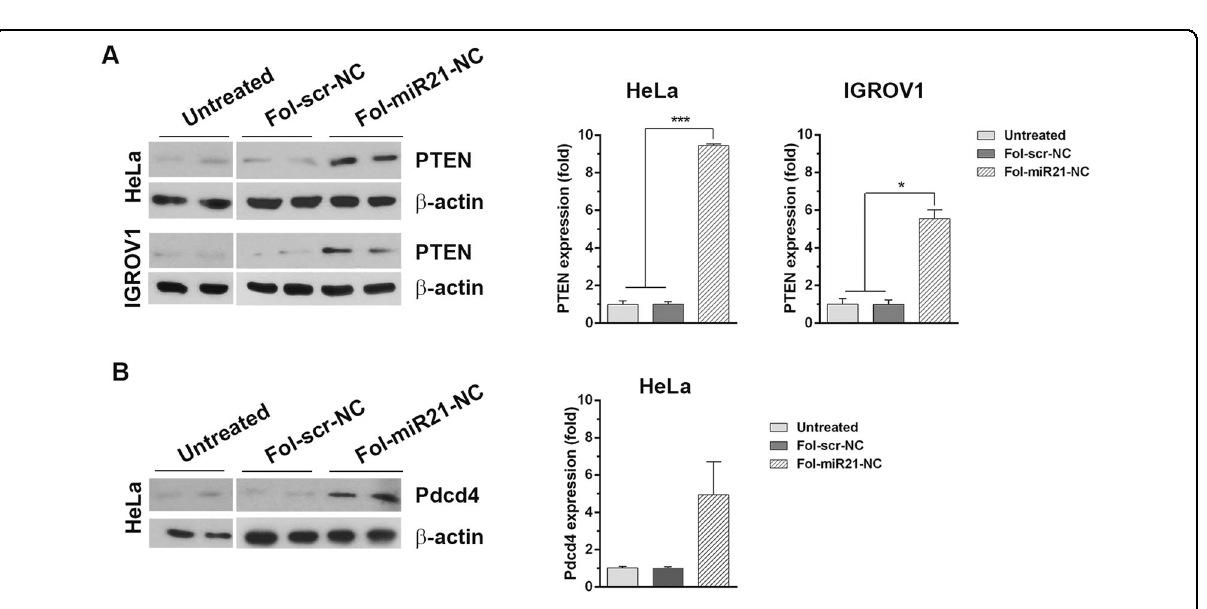
Therapeutic effects of Fol-miR21-NCs on cancer cells